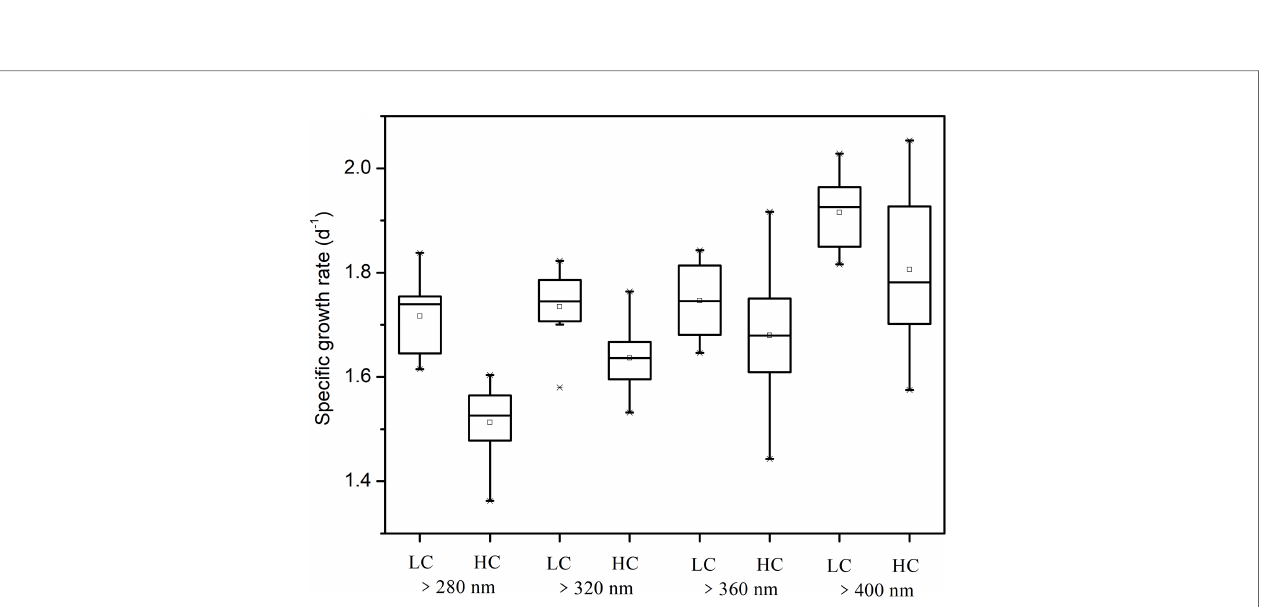
FIGURE 3 | Speci fi c growth rate of S . costatum acclimated to ambient (LC) and elevated CO 2 (HC) in different spectral treatments.